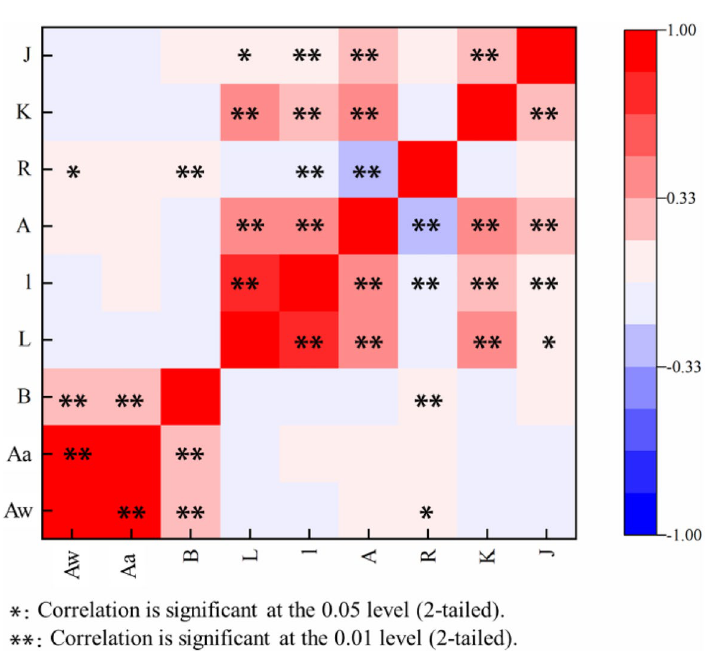
Figure 3. Correlation between rill cross-sectional asymmetry (RCA) and topographic